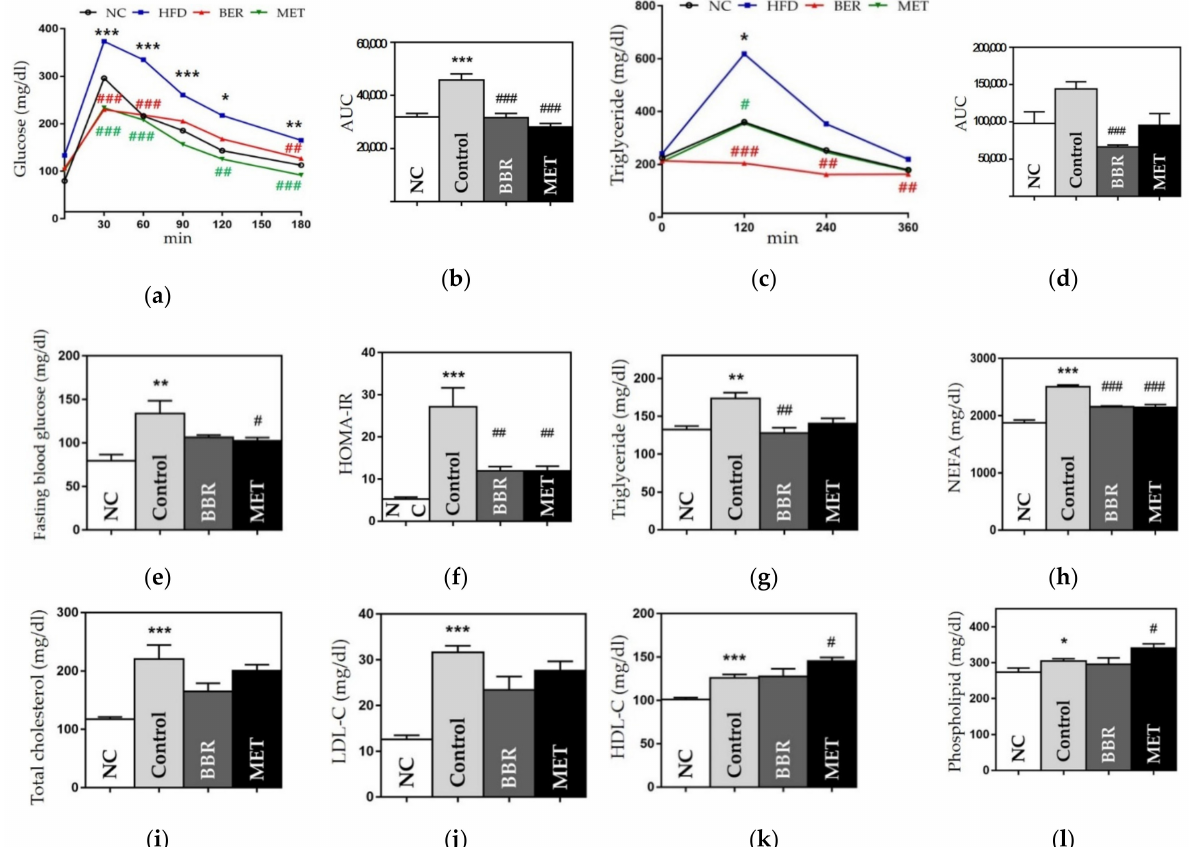
Figure 5. Glucose- and lipid metabolism-related outcomes. ( a ) OGTT results, ( b ) AUC of OGTT, ( c ) OFTT results, ( d ) AUC of OFTT, ( e ) fasting blood glucose, ( f ) HOMA-IR ( g ) triglycerides ( h ) NEFA, ( i ) total cholesterol level, ( j ) LDL cholesterol level, ( k ) HDL cholesterol level, and ( l ) phospholipid level. Data are presented as mean ± standard error of the mean (SEM). * p < 0.05, ** p < 0.01 and *** p < 0.001 vs. the NC group and # p < 0.05, ## p < 0.01 and ### p < 0.001 vs. the control group. AUC: area under curve, OGTT: oral glucose tolerance test, OFTT: oral fat tolerance test, HOMA-IR, homeostatic model assessment for insulin resistance, NEFA: non-esterified fatty acid, LDL: low-density lipoprotein, HDL: high-density lipoprotein NC: normal chow, HFD: high fat diet, BBR: berberine, MET: